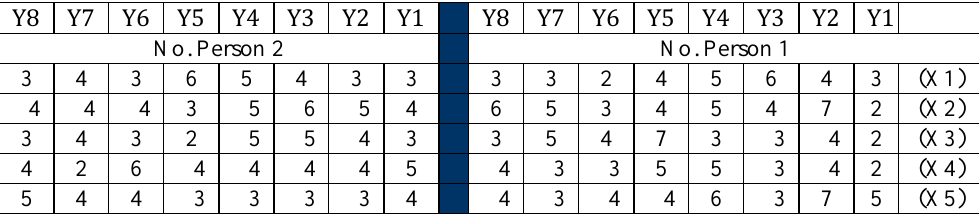
Table 10. Experts' opinions on competition-level characteristics based on management